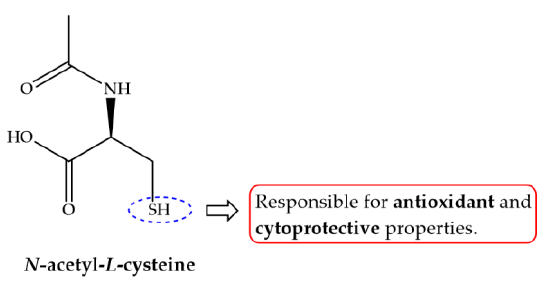
Figure 8. N -acetyl- L -cysteine (NAC) displays antioxidant and cytoproctive properties that are related to its free sulfhydryl group (blue elipse) which directly react with electrophiles including reactive radicals.